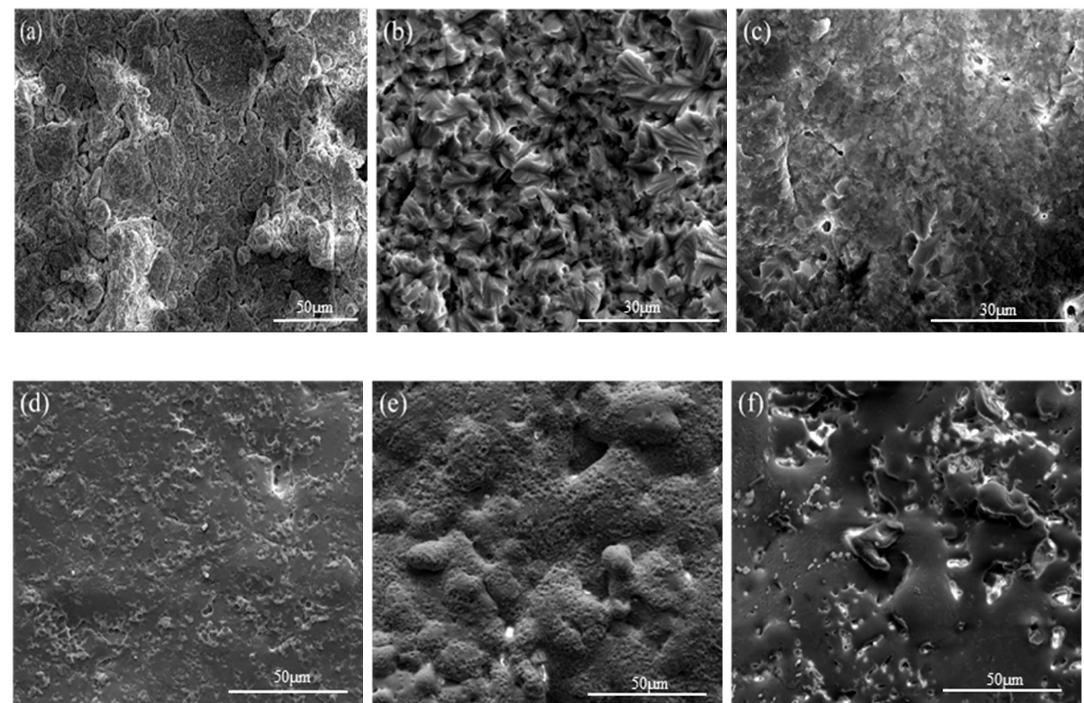
Figure 8. SEM images of the original glass-ceramics. ( a ) S1, ( b ) S2, ( c ) S3, ( d ) S4, ( e ) S5, and ( f ) S6.